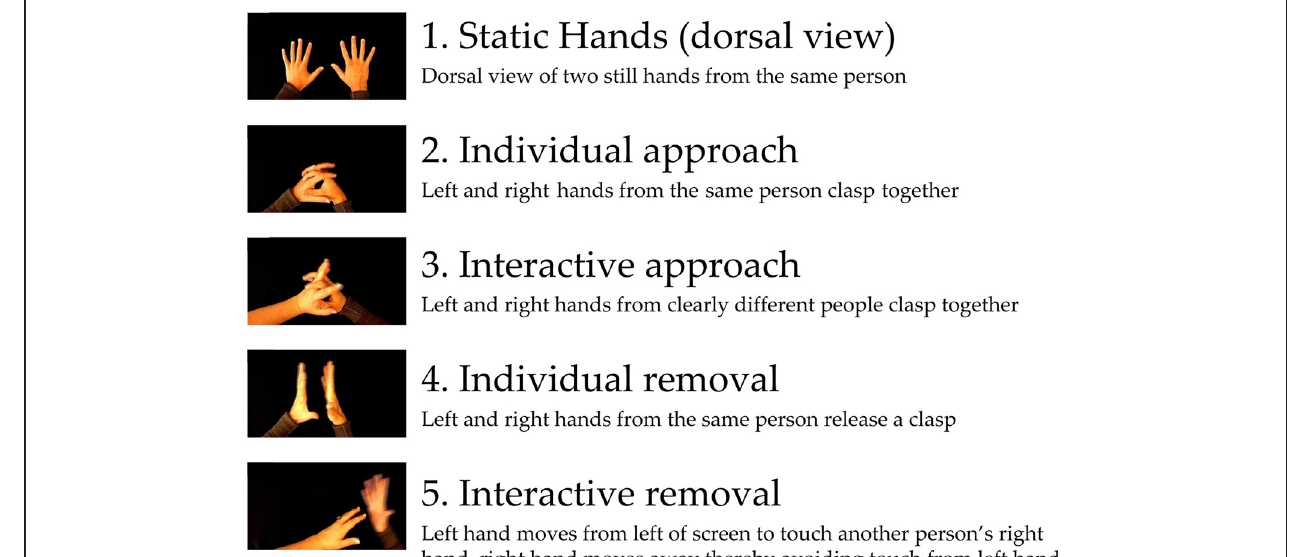
FIGURE 1 | Screenshots and descriptions of the five